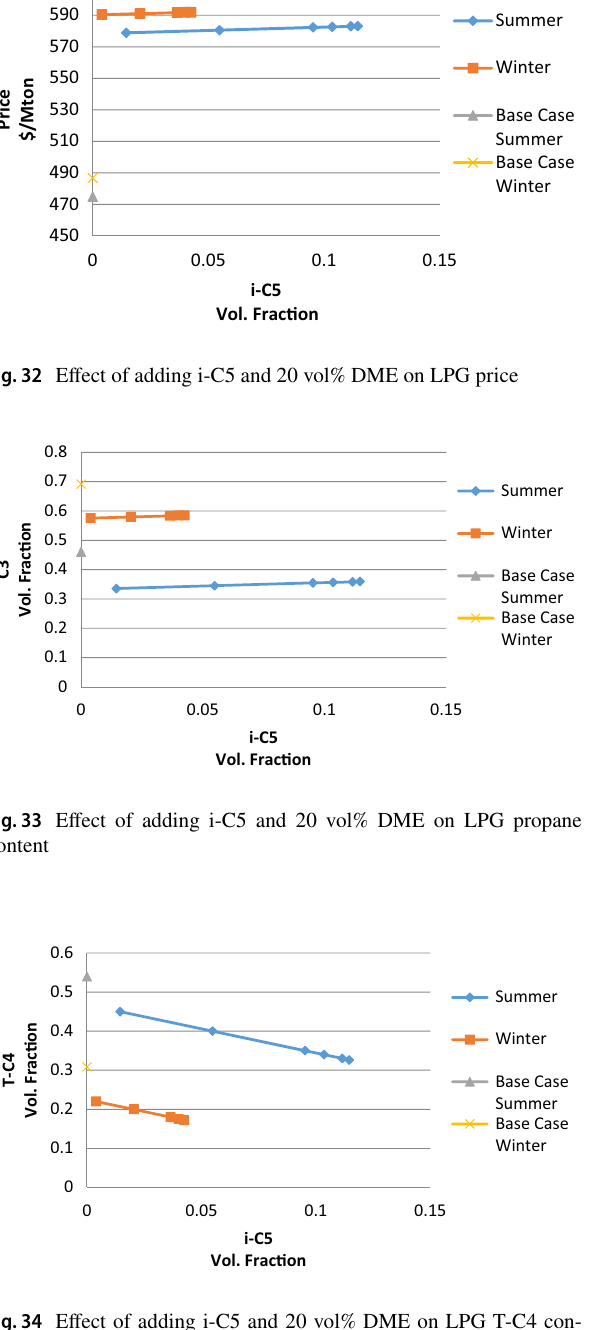
Fig. 34 Effect of adding i-C5 and 20 vol% DME on LPG T-C4 con- tent